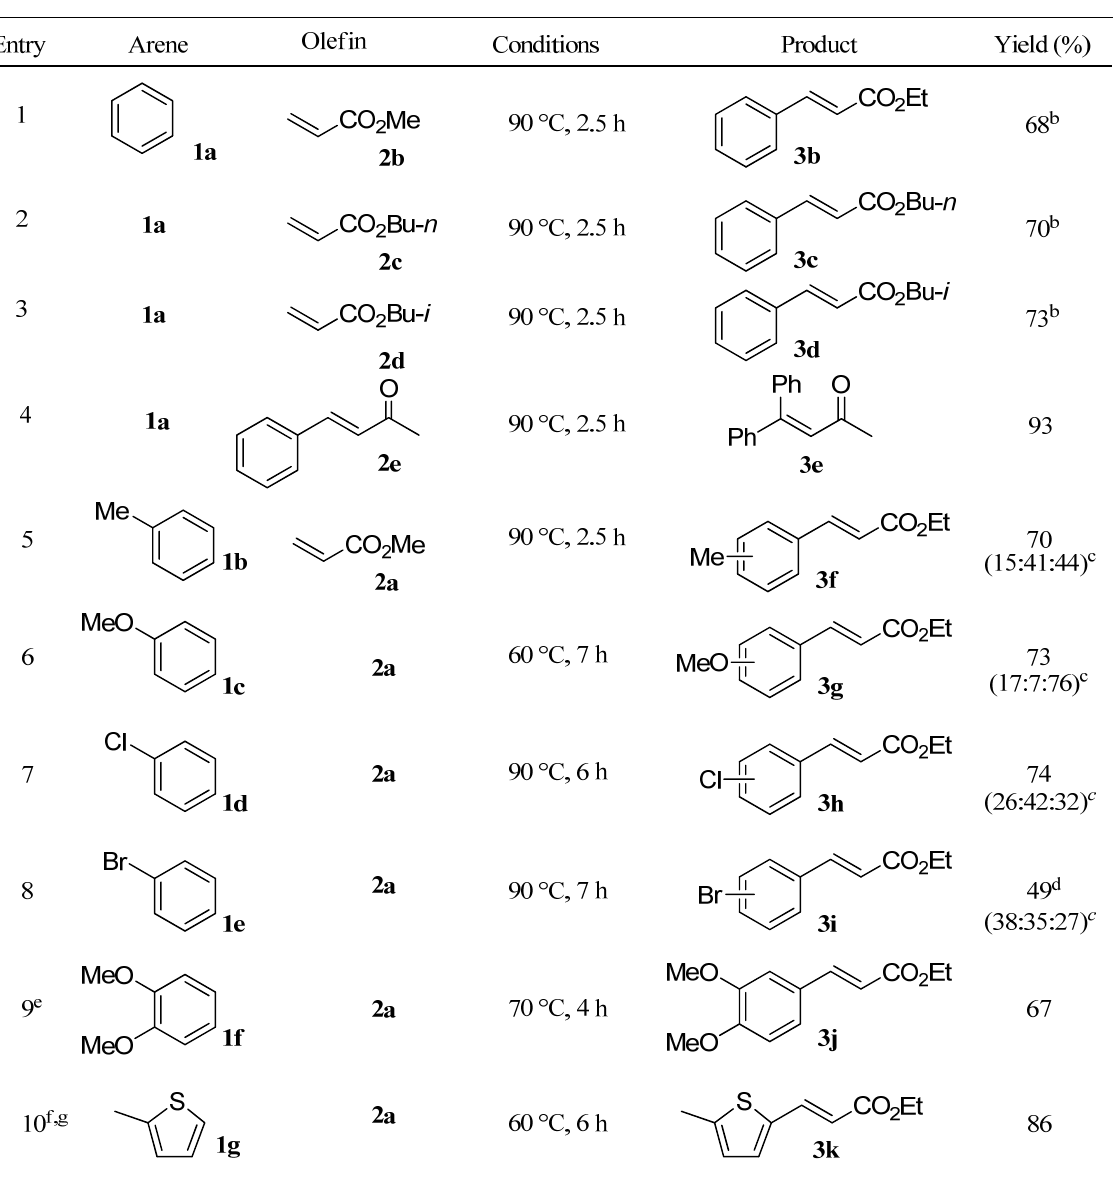
Table 2. Oxidative coupling of various arenes 1 and acrylates 2 catalyzed by Pd(II)/HPMoV.